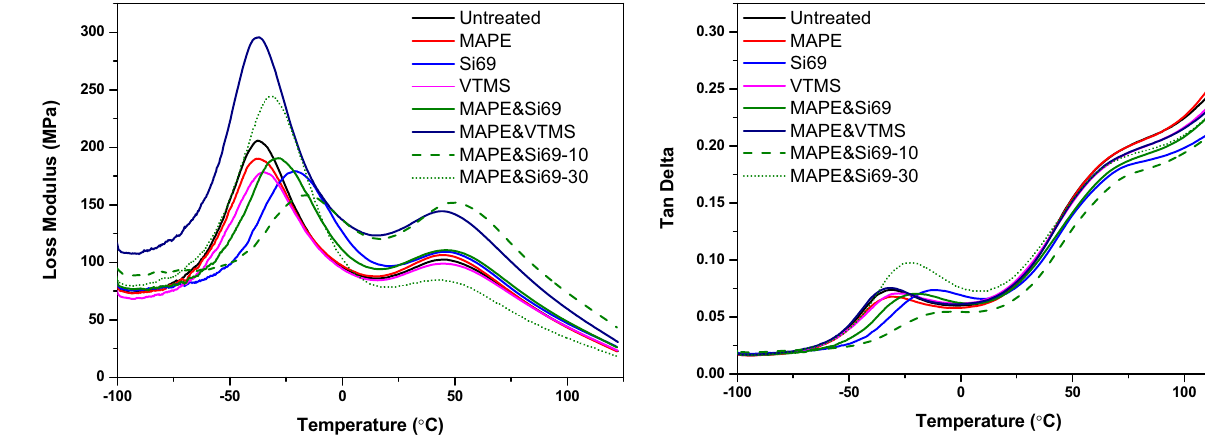
Figure 5: Loss modulus of untreated and coupling agent treated RubWPC as a function of temperature.